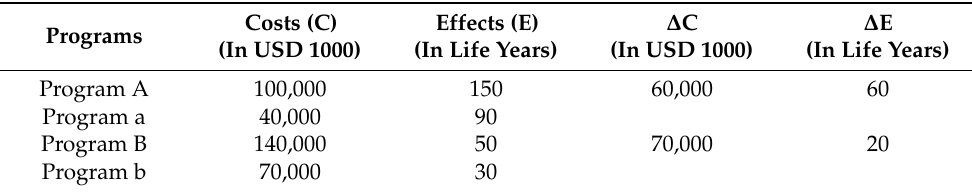
Table 1. Costs and effects of four hypothetical programs for resource